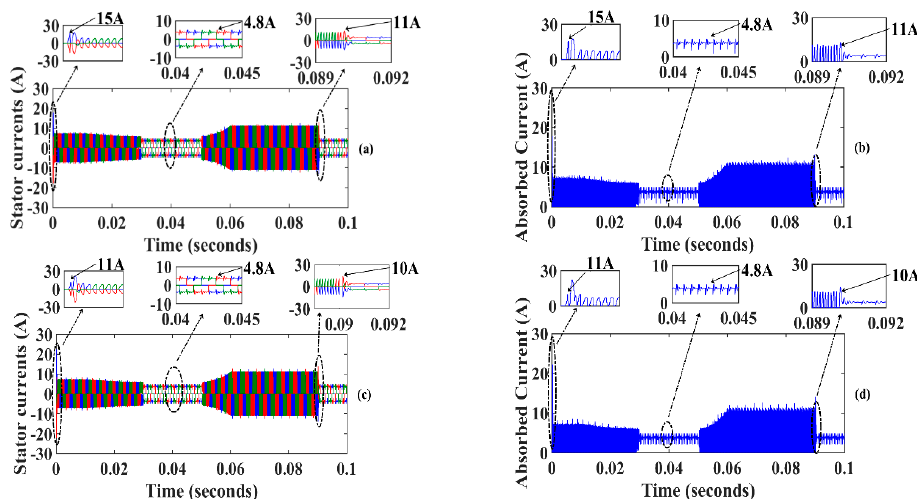
Figure 11. Phase and absorbed current waveforms for combined “with and without an R-C filter”: ( a , b ) C = 0.6 µF, and ( c , d ) C = 1.5 µF.